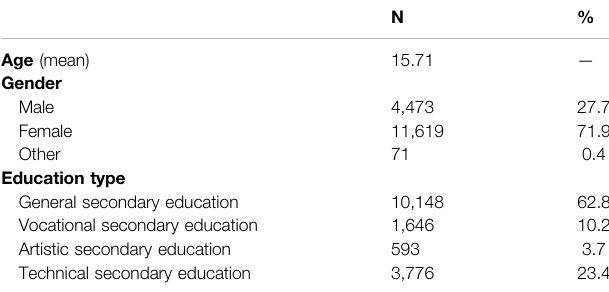
TABLE 1 | Sociodemographic characteristics of the sample (n =